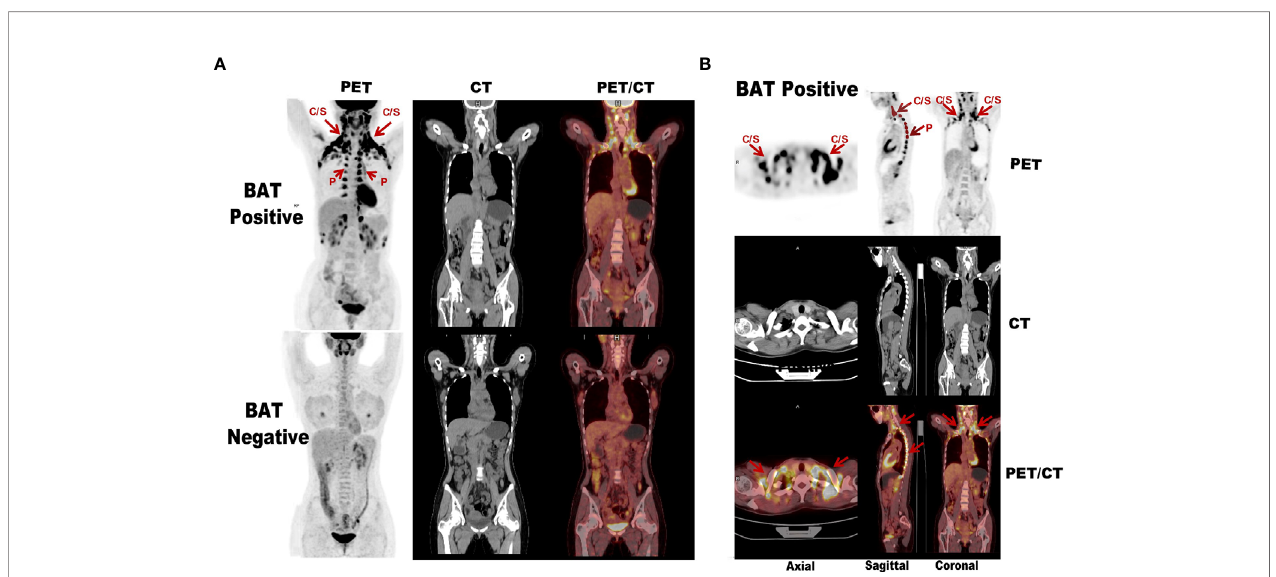
FIGURE 2 | Comparison diagram of subjects with and without activated BAT assessed by 18 F-FDG PET/CT. (A) The above images shows extended BAT uptake of 18 F-FDG in cervical, supraclavicular, axillary, and paravertebral regions in healthy adult. The below images The below image of the other subject with the same gender, similar age and BMI in whom PET/CT was performed in the same day shows no BAT uptake of 18 F-FDG in the same regions. (B) The subject with activated BAT mainly located in the central axis areas such as the cervical-supraclavicular and paravertebral on the PET maximum intensity projection. “ C/S ” means cervical/ supraclavicular and “ P ” denotes paravertebral (red arrows).